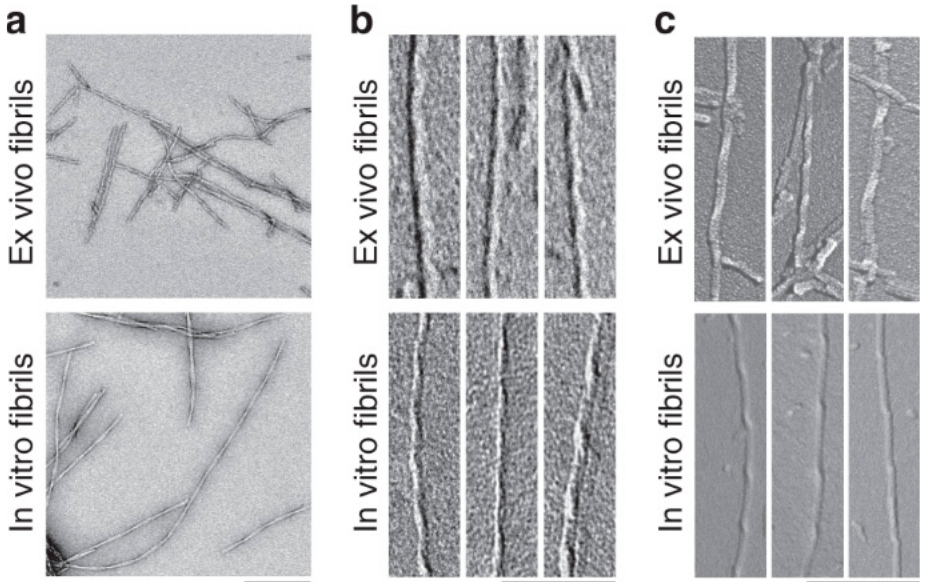
Figure 3. Different structures of brain-derived and in vitro formed A β fibrils. ( a ) Negative stain TEM images of brain-derived amyloid fibrils or in vitro formed A β fibrils. Scale bar: 200 nm. ( b , c ) TEM ( b ) and SEM ( c ) images of brain-derived amyloid fibrils or in vitro formed A β fibrils after platinum side shadowing. Scale bars: 100 nm. The figure is reprinted from [18].